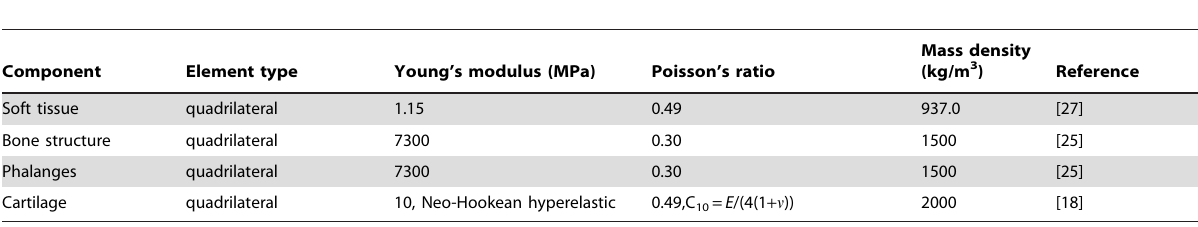
Table 1. The material properties and element types used in the foot finite element model.